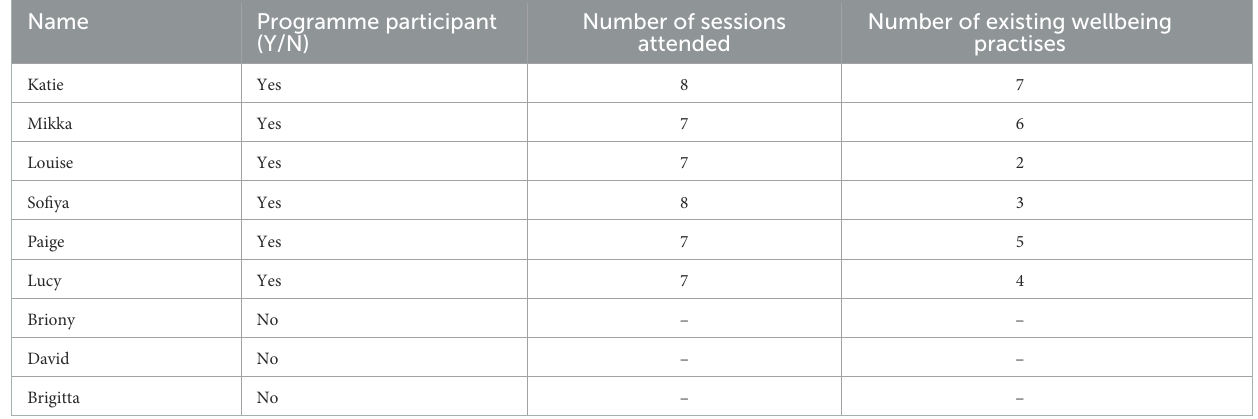
TABLE 2 Descriptive data for participants that completed the qualitative